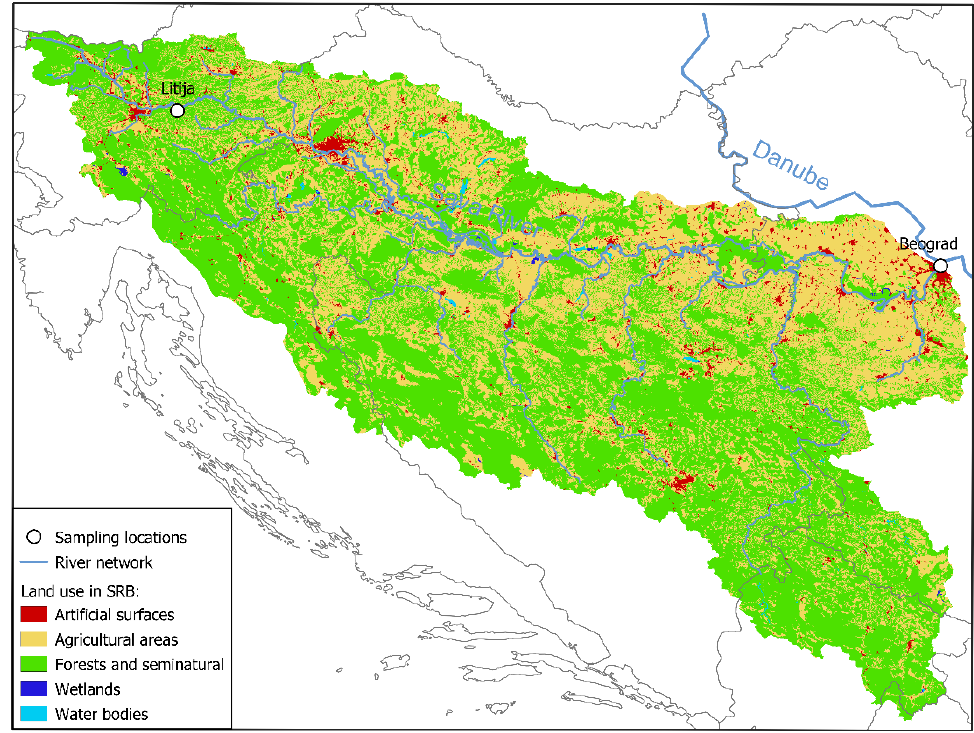
Figure 1. The Sava River Basin, indicating the sampling locations and land